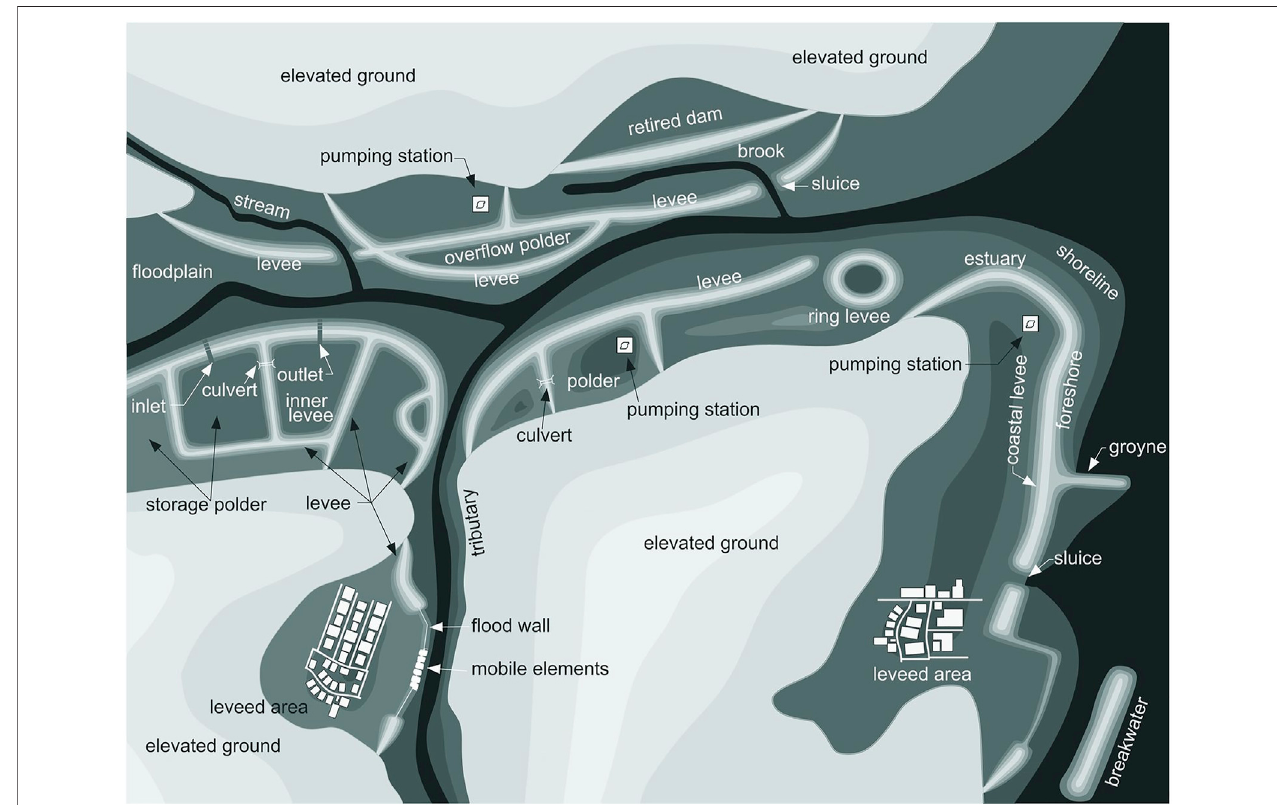
FIGURE 5 | Schematic representation of a coastal fl ood protection system (CIRIA MEDDE USACE, 2013). Credit: Reinhard Pohl, Technische Universität Dresden.